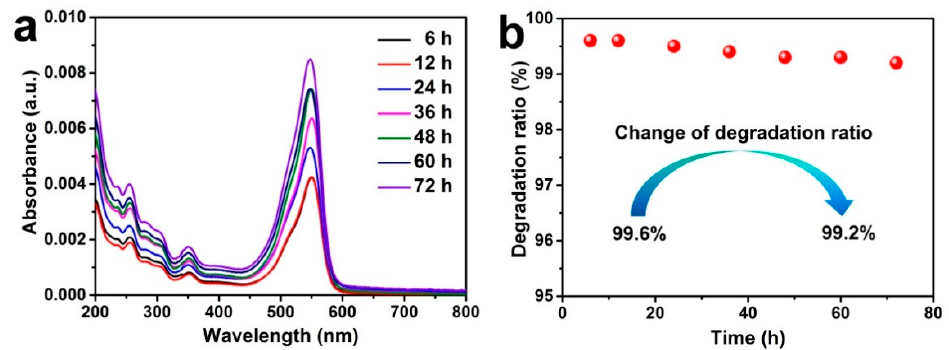
Figure 6. UV-vis spectra ( a ) and the degradation ratios ( b ) of the RhB solution for different times during the continuous-flow photodegradation under simulated solar irradiation.